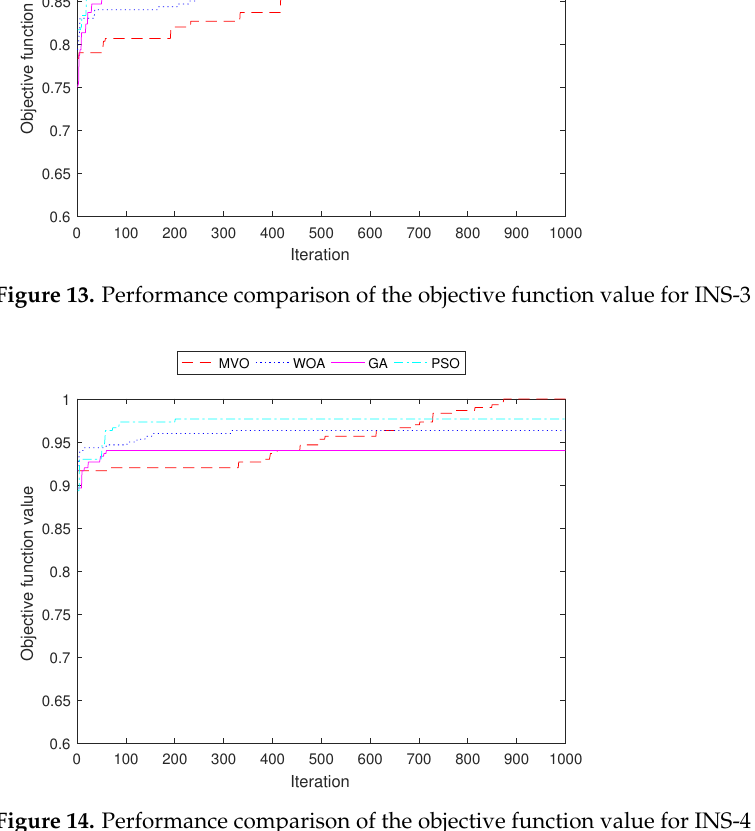
Figure 14. Performance comparison of the objective function value for INS-4 with 150 mesh